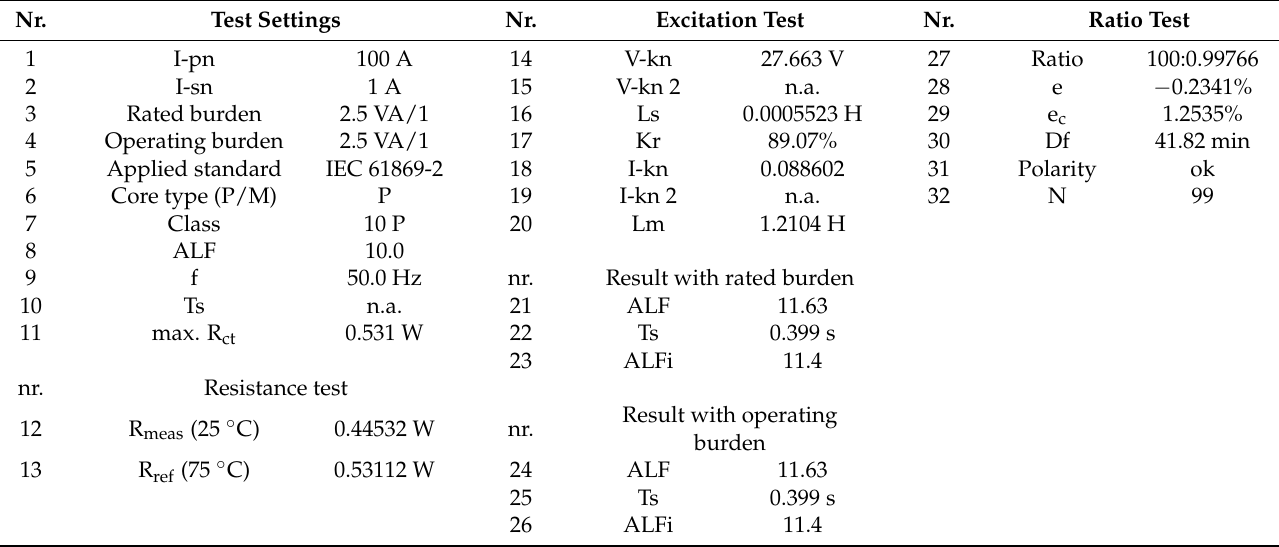
Figure 6. Test result of CT magnetization. Following the formula obtained using the 4 th degree polynomial approximation from the data processing program: L m = −0.0438·I ct4 + 0.2079·I ct3 − 0.3636·I ct2 + 0.3834·I ct + 0.031